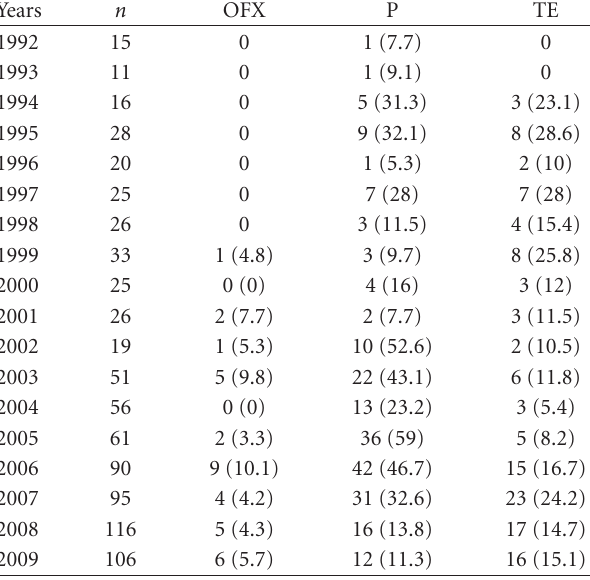
Table 2: Neisseria gonorrhoeae strains with intermediate suscepti- bility over the study period 1992–2009. n is the total number of intermediate strains for that particular year. Percentage is shown in parenthesis